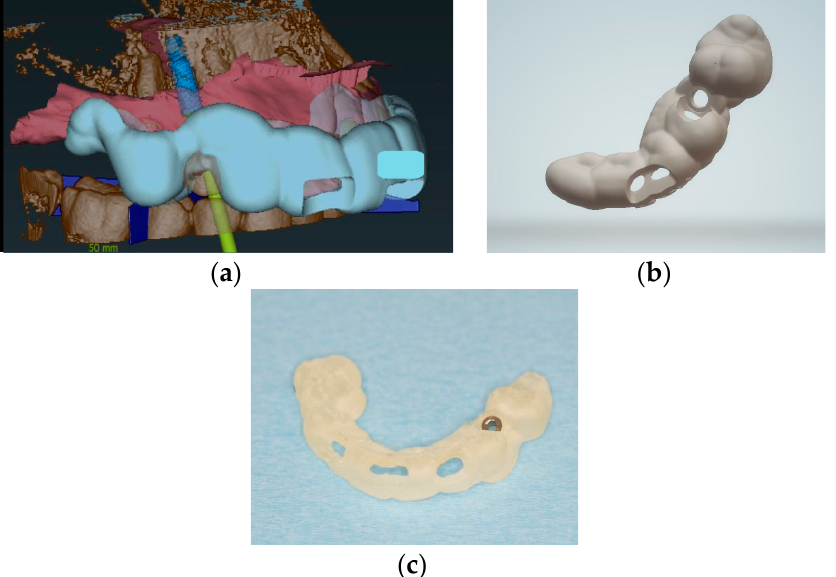
Figure 4. ( a ) Digital design for implant position and surgical template, coDiagnostics; ( b ) digital design of the surgical template; ( c ) surgical template with a sleeve in region 14.